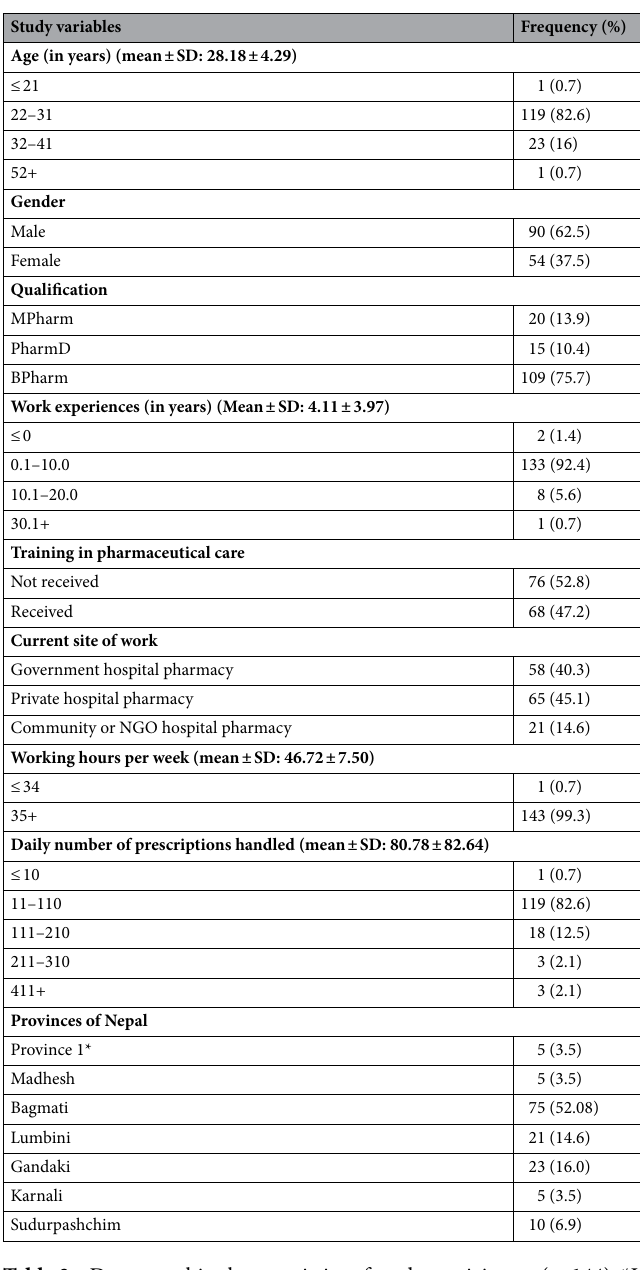
Table 2. Demographic characteristics of study participants (n: 144). *Unnamed as of 5thdJune,